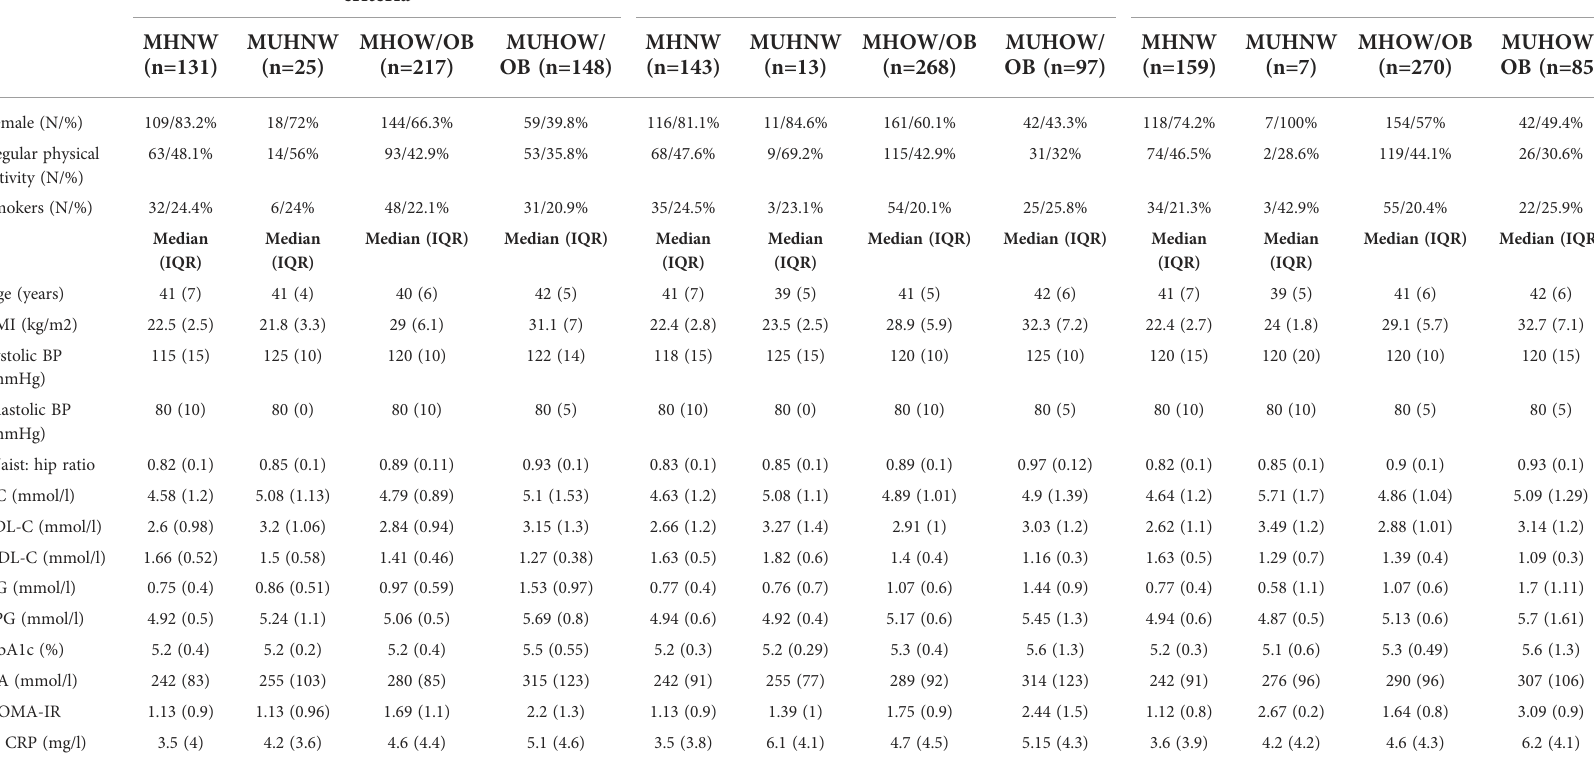
TABLE 1 Baseline clinical and biochemical characteristics of the study cohort, strati fi ed according to different metabolic health de fi